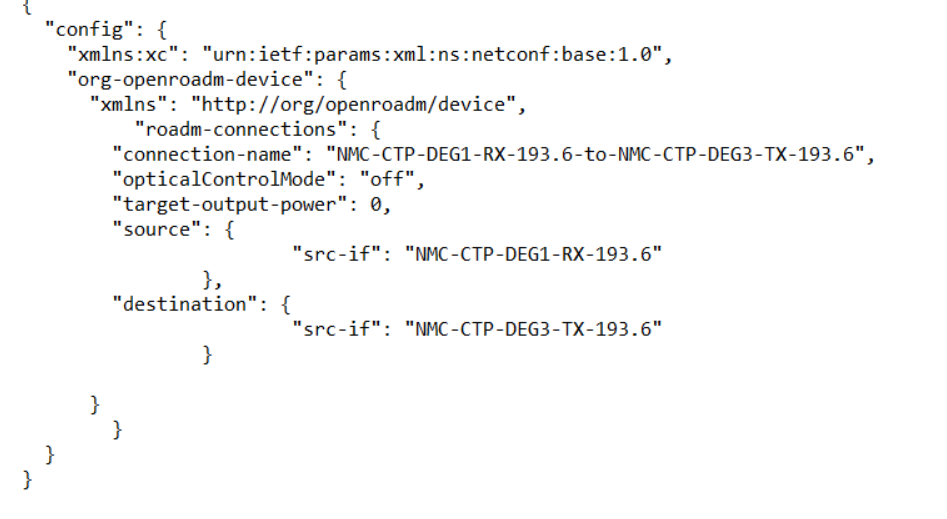
Figure 5. JSON model of a connection between ROADM devices. Listing 2. Pseudo-code of one of the M ROADM